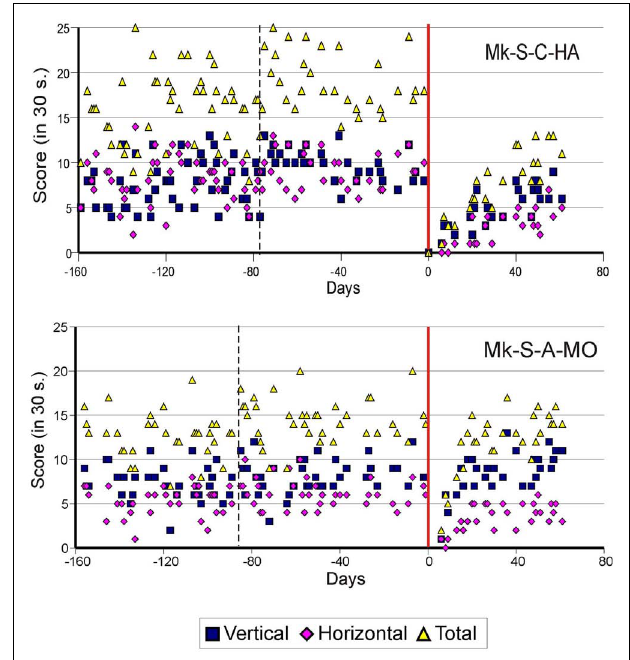
FIGURE 2 | Graphic representation of the number of pellets retrieved in 30s pre- and post-lesion during multiple daily sessions for two representative monkeys subjected to spinal cord lesion (Mk-S-C-HA and Mk-S-A-MO) .The red line represents the lesion date. Negative days along the abscissa are for daily sessions pre-lesion whereas positive days are for daily sessions post-lesion.The pink diamonds and the blue squares represent the number of pellets retrieved from horizontal and vertical slots, respectively.The total number of retrieved pellets in 30s is represented by the yellow triangles.The vertical dashed line separates the initial learning phase on the left from the more stable pre-lesion plateau phase. Modified from Freund et al. (10, 11,